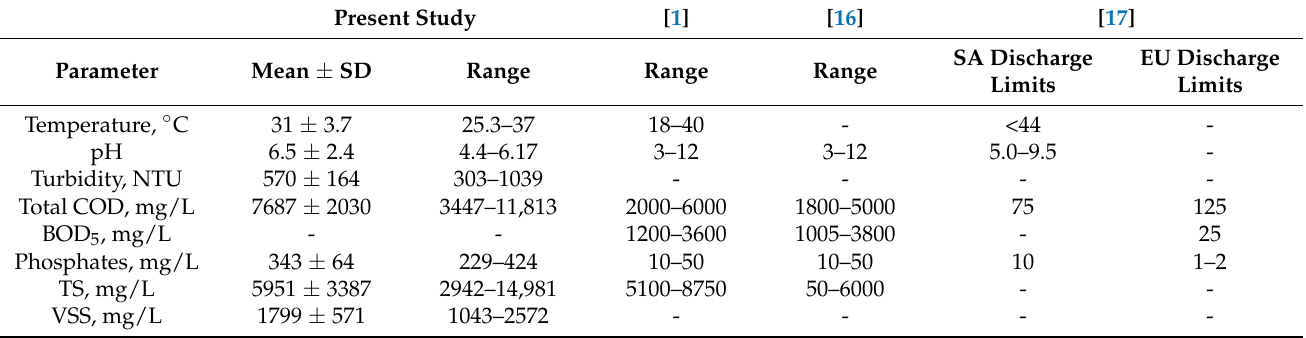
Table 1. Brewery wastewater composition and dewatering limits in SA and